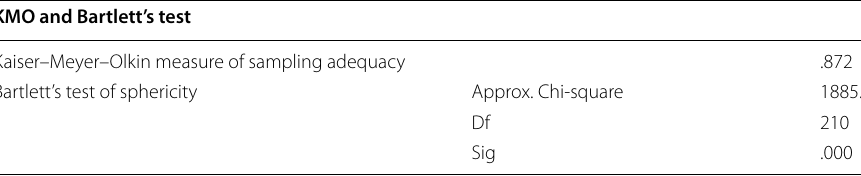
Table 3 Results of KMO and Bartlett’s test KMO and Bartlett’s test